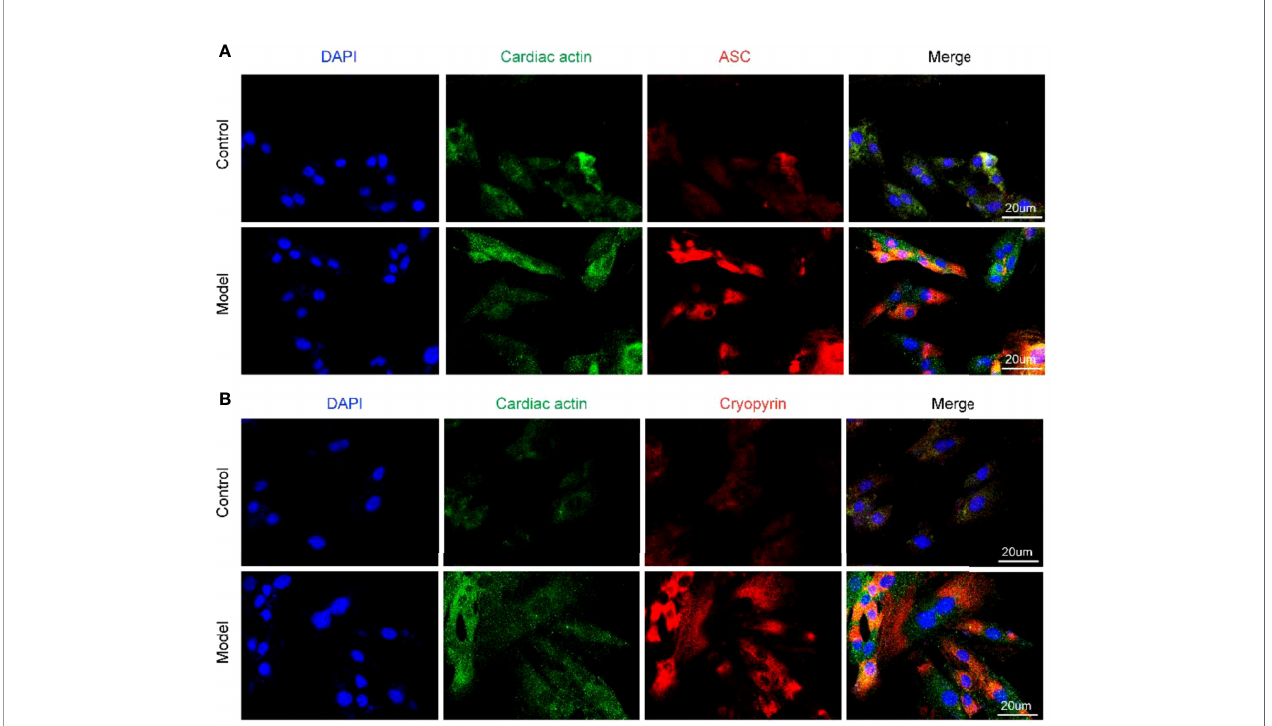
FIGURE 2 | Different components of NLRP3 in fl ammasome are activated under OGD induction in H9c2 cells. (A) The protein expression levels of the ASC (red color) in H9c2 by immuno fl uorescence, and the slides were counterstained with DAPI (blue). (B) The protein expression levels of the Cryopyrin (red color) in H9c2 by immuno fl uorescence, and the slides were counterstained with DAPI (blue).